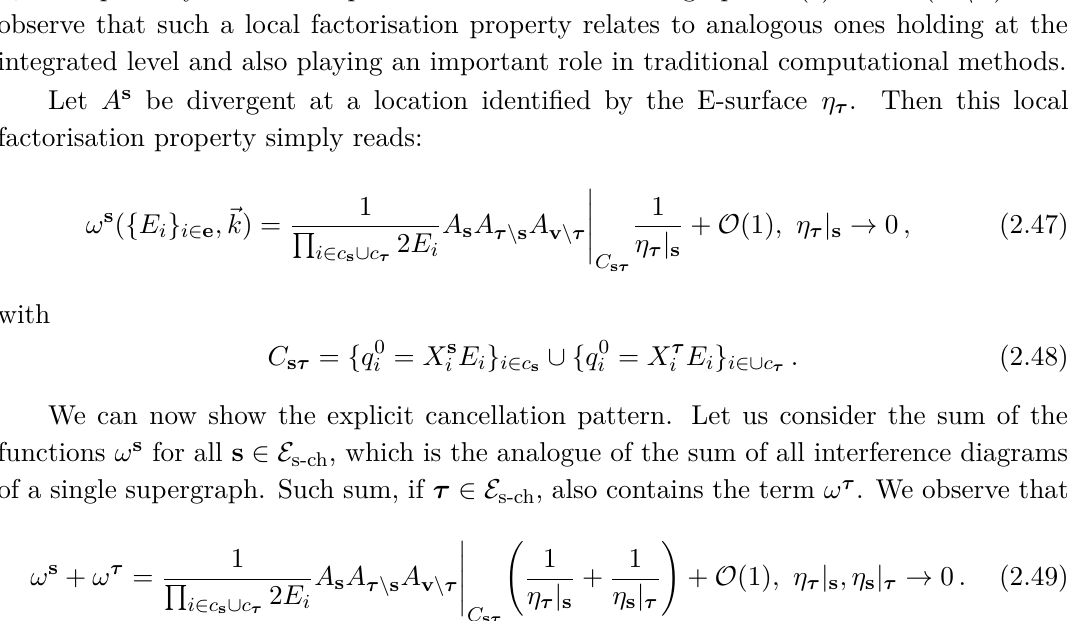
Figure 6. Two different interference diagrams, corresponding to Cutkosky cuts c s and c τ . The two Cutkosky cuts identify a singularity of the amplitudes, η identify the on-shell energy flow necessary for the particles in δ ( τ \ s ) to participate in a physical